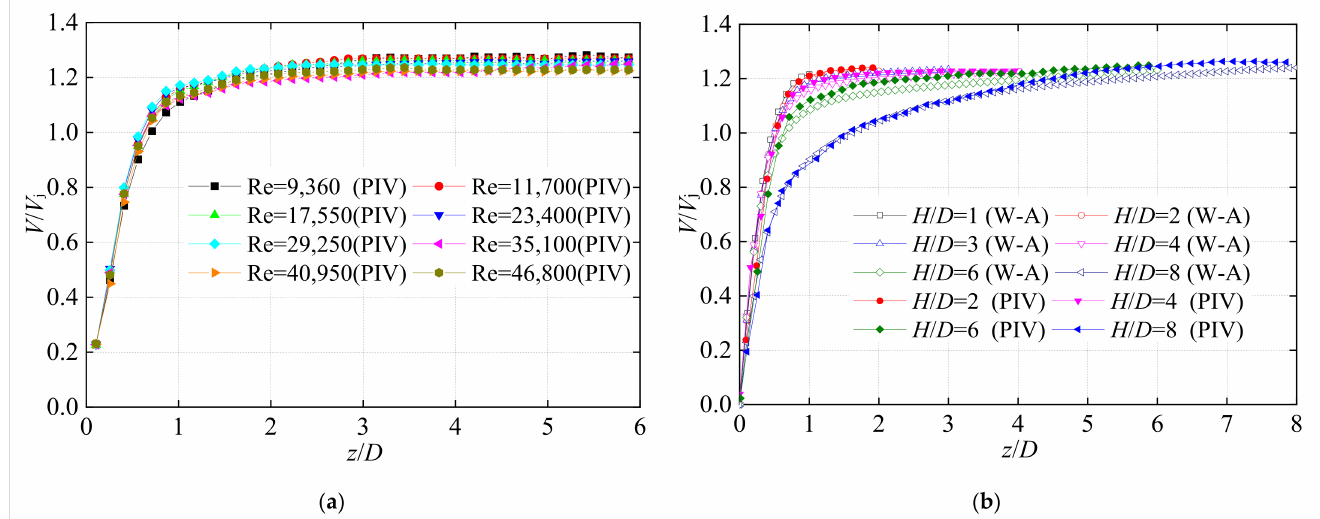
Figure 14. Distribution of dimensionless velocity V/V j on the axis of the jet: ( a ) different Reynolds numbers; ( b ) different impact